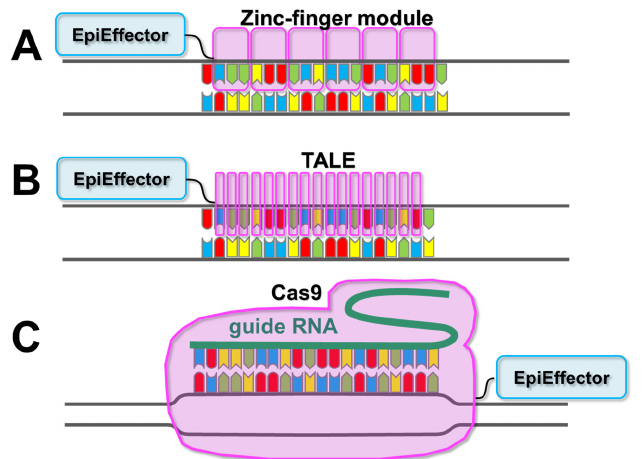
Figure 2. Schematic diagram of the DNA recognition domains available for epigenomic-modifying enzymes. ( A ) In zinc-finger arrays, each zinc-finger module recognizes three nucleotides. ( B ) In transcription activator-like effectors (TALEs), each repeat recognizes one nucleotide. ( C ) In clus- tered regulatory interspaced short palindromic repeats (CRISPR)/CRISPR-associated protein 9 (Cas9) (CRISPR/Cas9), one strand of the target site is recognized through Watson–Crick base pairing by a bound guide RNA. The attached effector domain (EpiEffector) is indicated by a blue shape. For details on EpiEffectors, please refer to Table 1 and earlier reviews [37,41,43–45].